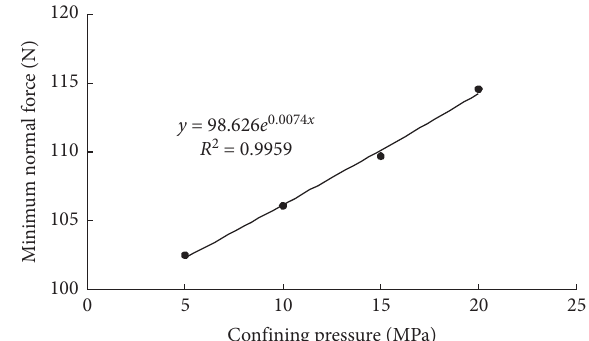
Figure 14: Relation curve between the confining pressure and the minimum normal force on the contact